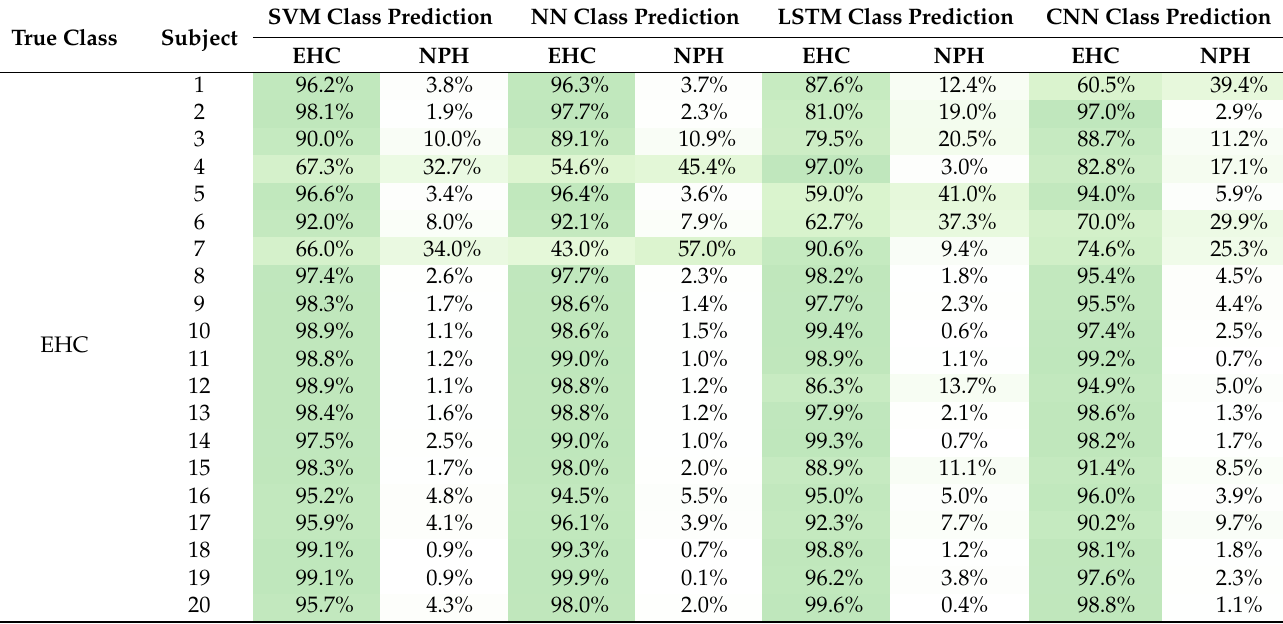
Table 4. The table displays the percentages of strides classified by the four classifiers: support vector machine (SVM-stride), feedforward neural network (NN-stride), long short-term memory neural network (LSTM) and convolutional neural network (CNN). Using at least 20 iterations for the Monte Carlo cross-validation, all subjects are considered in the test set at least once. Green represents values closer to 100%, and white indicates values closer to 0%